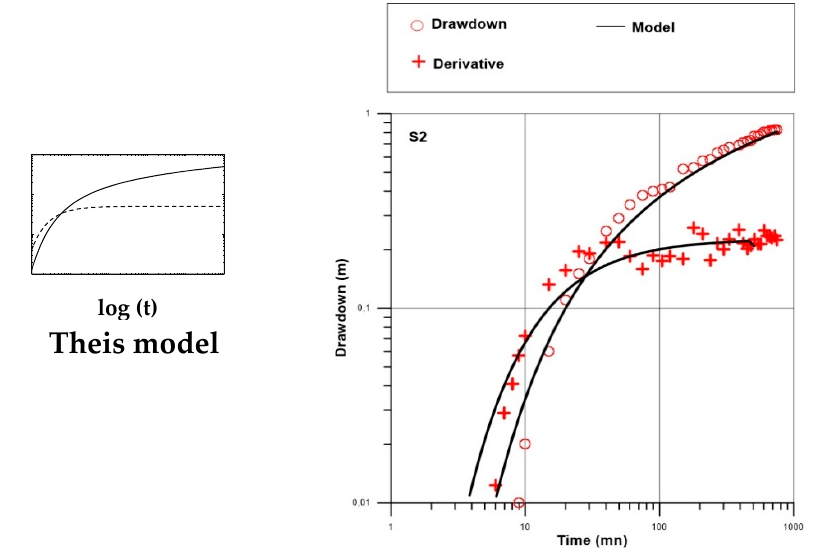
Figure 10. Interpretation of pumping test S1/S2: diagnostic plot ( left ) and data superimposed with a fitted Theis model ( right ).